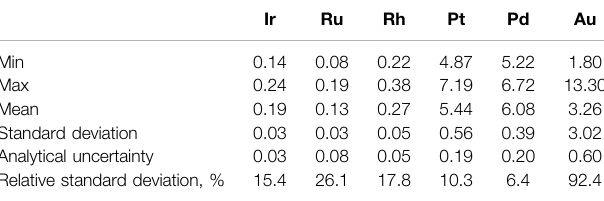
TABLE 3 | Summary statistics for 12 samples and 3 duplicates of Cone Mt. 1004.